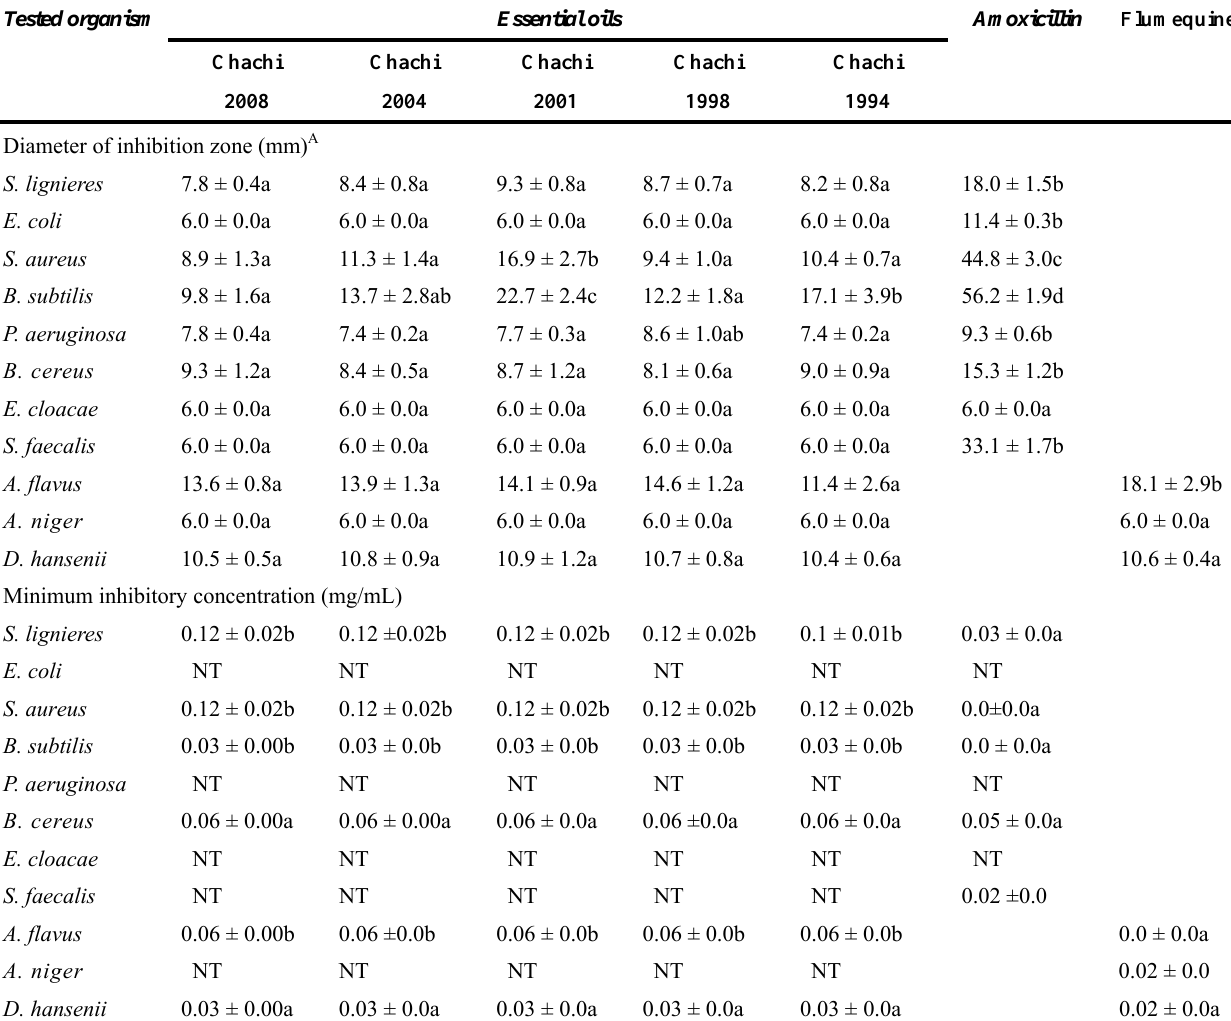
NT: not tested. Values are means ± standard deviation of three separate experiments. Different letters in a row indicate significant differences. A diameter of inhibition zone (mm) including disc diameter of 6